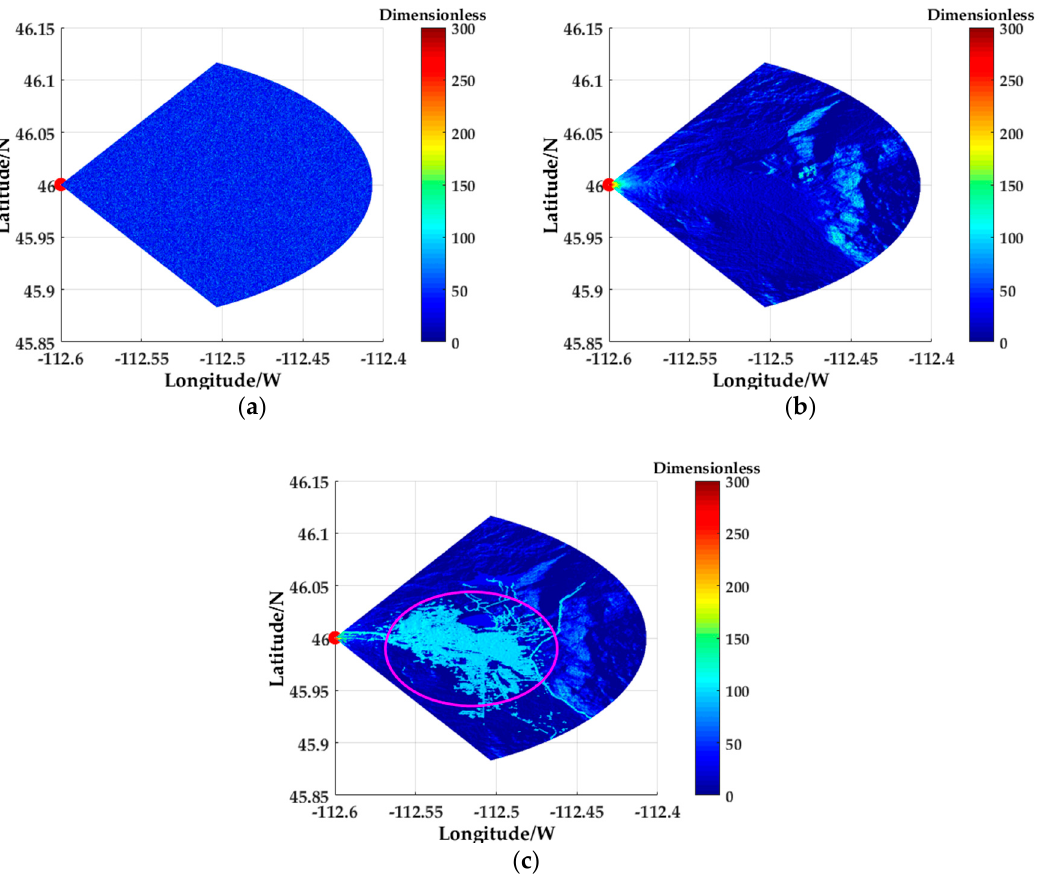
Figure 9. Comparison of backscattering coefficients in different methods: ( a ) Gaussian distribution backscattering coefficients based on a traditional statistical model; ( b ) The backscattering coefficients obtained by using DEM data proposed in [13]; ( c ) The backscattering coefficients based on the method proposed in this paper.